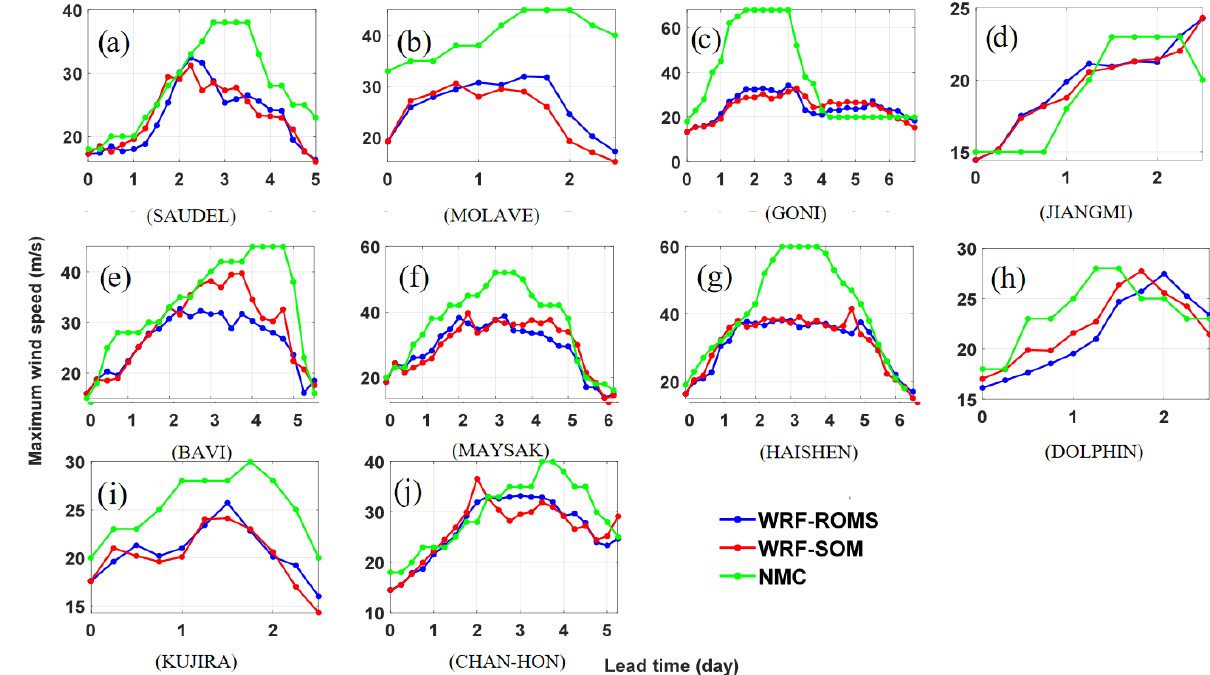
Figure 10. The maximum wind speed (MWS) of typhoon simulated in the WRF-SOM (red) and WRF-ROMS (blue) compared with National Meteorological Center (NMC) (green) during typhoon season (NMC data, http://typhoon.nmc.cn/web.html, last access: 27 January 2023).